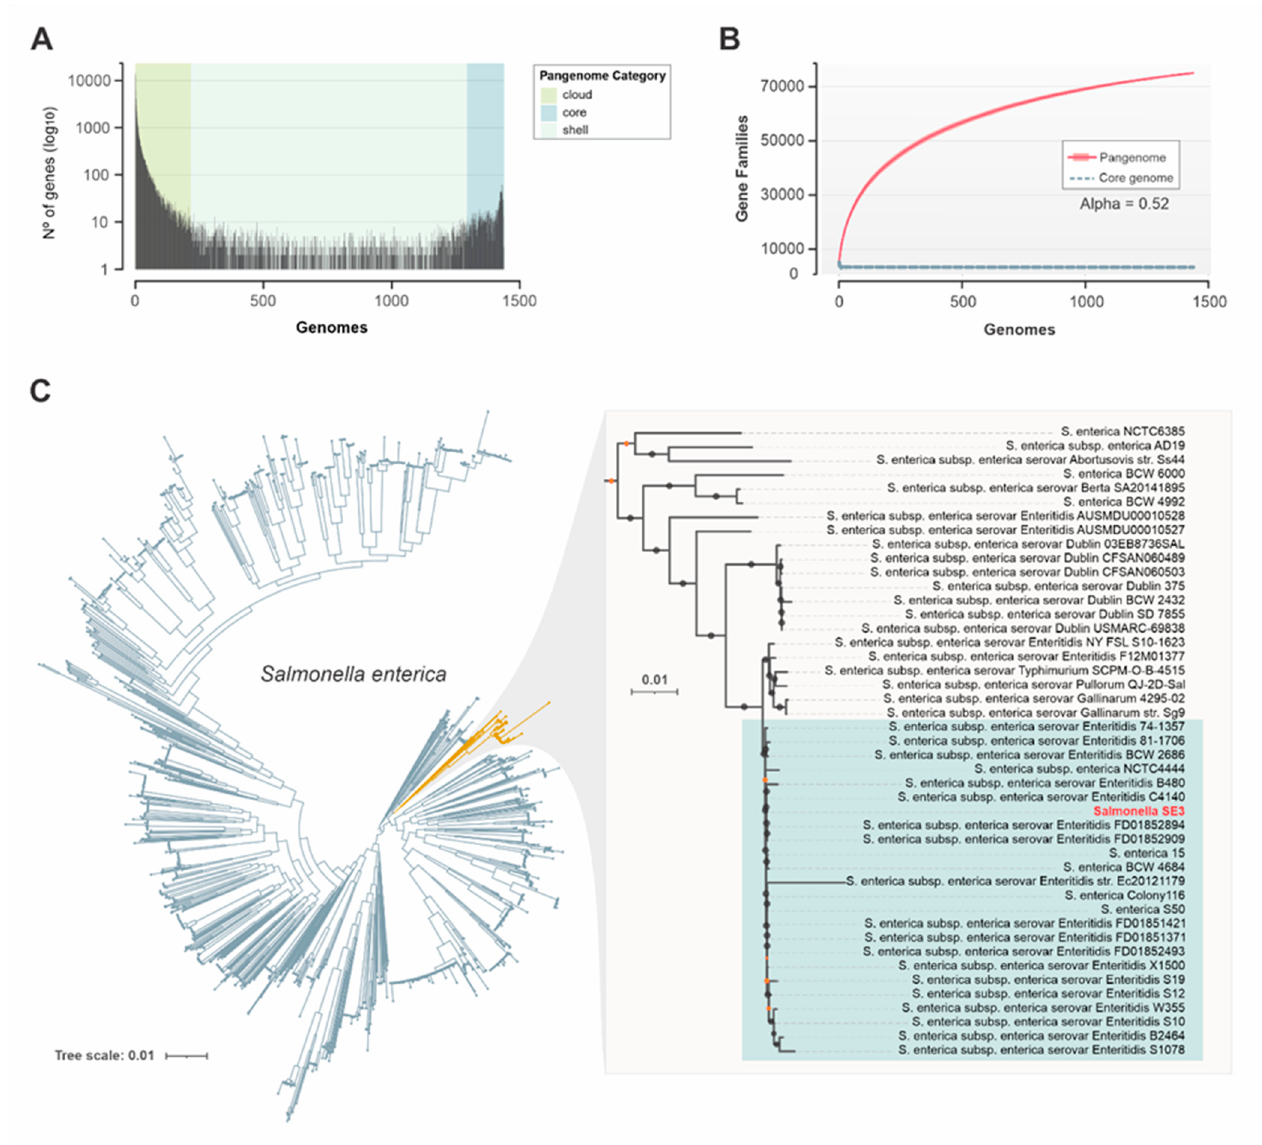
Figure 3. Pangenome of Salmonella enterica and phylogeny of Salmonella SE3. ( A ) Gene frequency of S. enterica pangenome. ( B ) Number of gene families in the S. enterica pangenome. The cumulative curve (in red) and an alpha value of the Heaps Law less than one (0.52) supports an open pangenome. ( C ) core-genome SNP tree of Salmonella enterica highlighting the phylogenetic group contained the Salmonella SE3 genome. The monophyletic clade containing the serovar Enteritidis of S. enterica is shaded in cool grey. Bootstrap values below and above 70% are represented by blue and dark-grey dots, respectively.